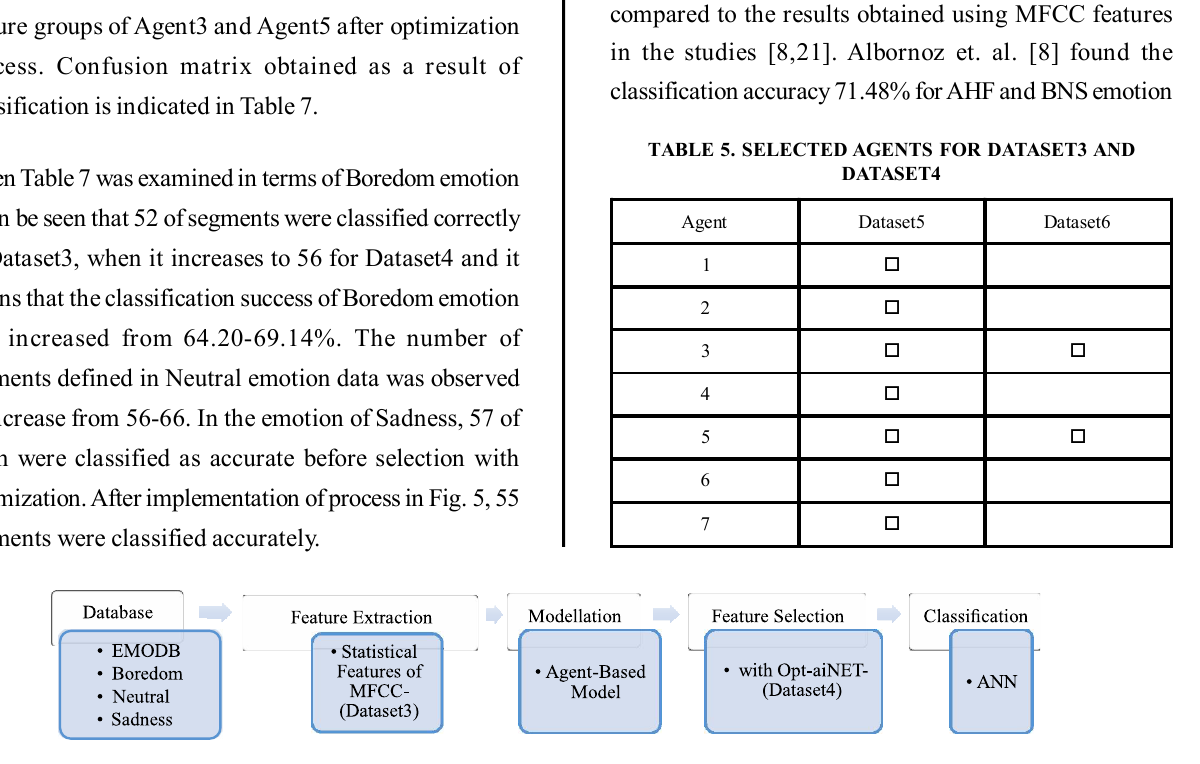
FIG. 5. THE STEPS OF PROCESS FOR DATASET3 AND DATASET4 TABLE 6. THE RECOGNITION RATE AND CLASSIFICATION ACCURACY FOR DATASET3 AND DATASET4